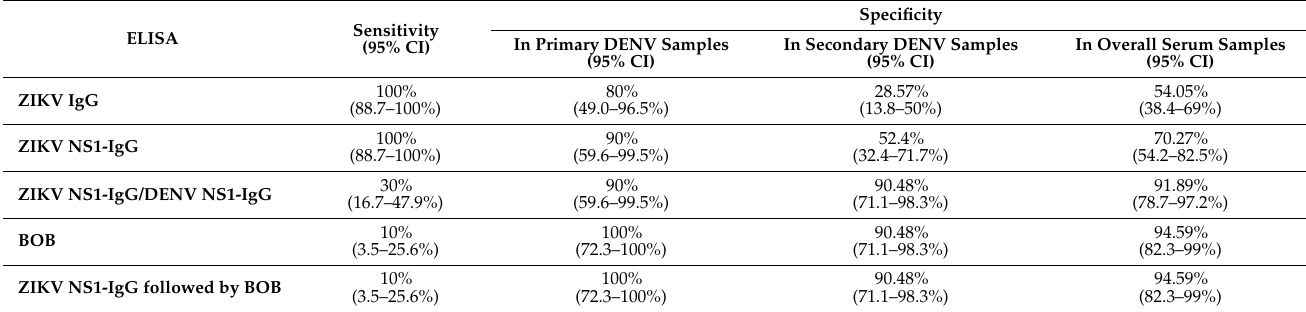
Table 2. Sensitivity and specificity to ZIKV of enzyme-linked immunosorbent assays.